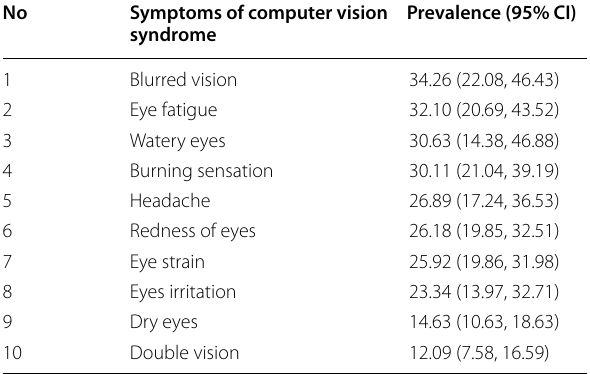
Table 3 Prevalence of computer vision syndrome symptoms among employees who use the computer in Ethiopia